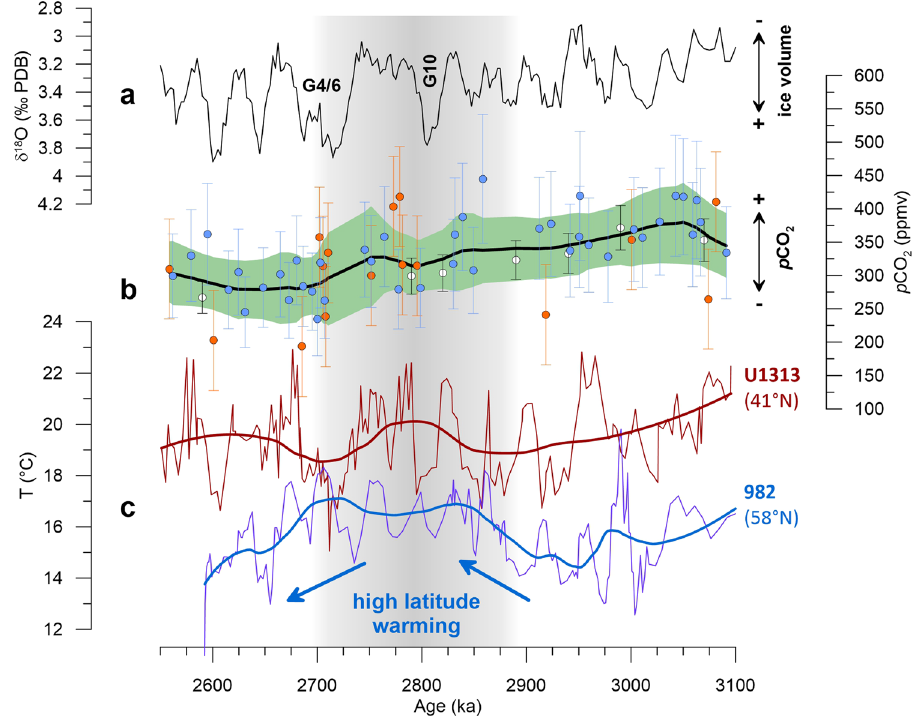
Fig. 1 Overview of global climate dynamics during the Plio – Pleistocene transition. a Ice volume reconstruction with Glacials G4/6 and G10 denoted 44 ( b ) different atmospheric p CO 2 reconstructions for the Plio – Pleistocene transition (white circles; 2 orange circles; 3 blue circles 4 ); with LOESS smoother (black line; smoothing factor 0.07) and 95% con fi dence interval (green shading) derived from a Monte Carlo Simulation with 1000 iterations. c Sea surface temperature (SST) records of mid-latitude Site U1313 (dark red line; thick line indicates 0.5 LOESS smoother; see Fig. 2 for site location) 43 and high-latitude Site ODP 982 (blue line; thick line indicates 0.3 LOESS smoother; see Fig. 2 for site location) 64 on the revised age model of 41 . The grey shading indicates the interval of anomalous SST warming in the high-latitude North Atlantic as depicted by blue